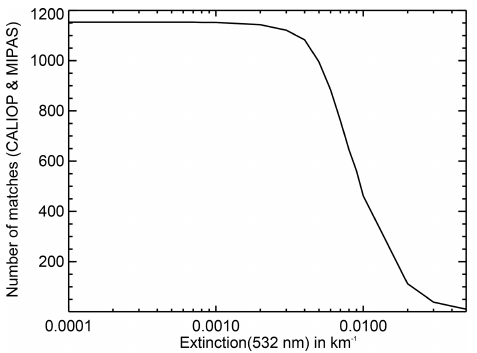
Figure 6. Number of matches for MIPAS and CALIOP aerosol de- tections as a function of the altitude-variable extinction threshold for CALIOP given at 18km.